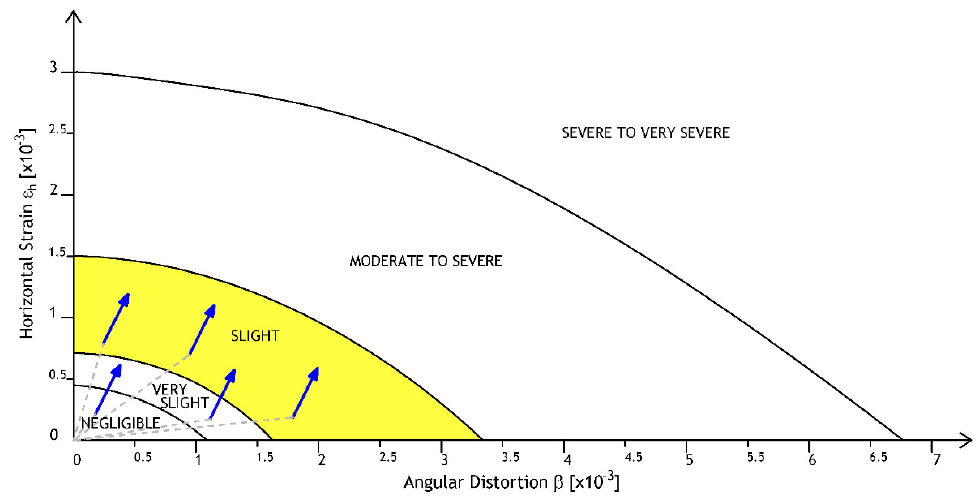
Figure 14. Damage assessment for the considered case study building wall, based on Boscardin and Cording scheme [28], as a function of the angular distortion β and horizontal strain ε h